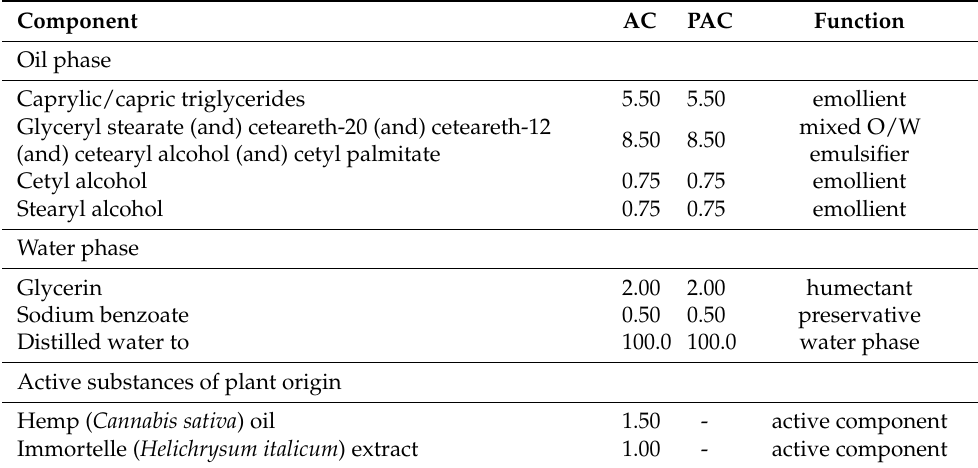
Table 1. Qualitative and quantitative compositions (%, ( w/w )) of cream samples: active cream (AC) and placebo cream